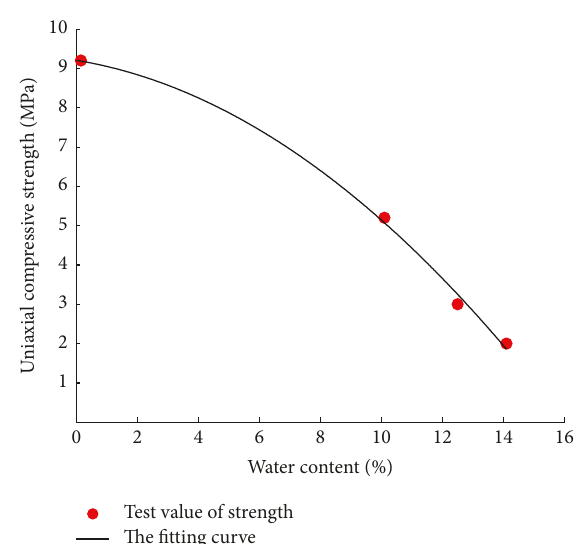
Figure 10: Fitting curve between the uniaxial compressive strength and water content.